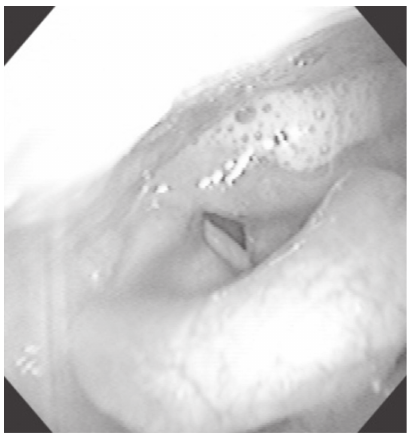
Figure1:Laryngoscopicexamination.Laryngoscopyrevealedsaliva pooling in the left piriform sinus. No eruption was observed in the pharyngolaryngeal